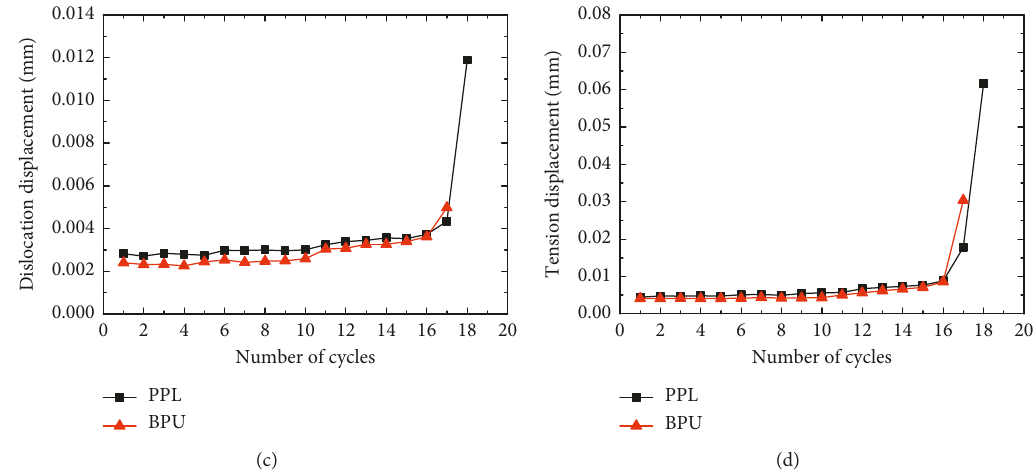
Figure 13: Displacement evolution curves at the peak point of loading stress and the bottom point of unloading stress: (a) dislocation displacement of localization band A; (b) tension displacement of localization band A; (c) dislocation displacement of localization band B; (d) tension displacement of localization band